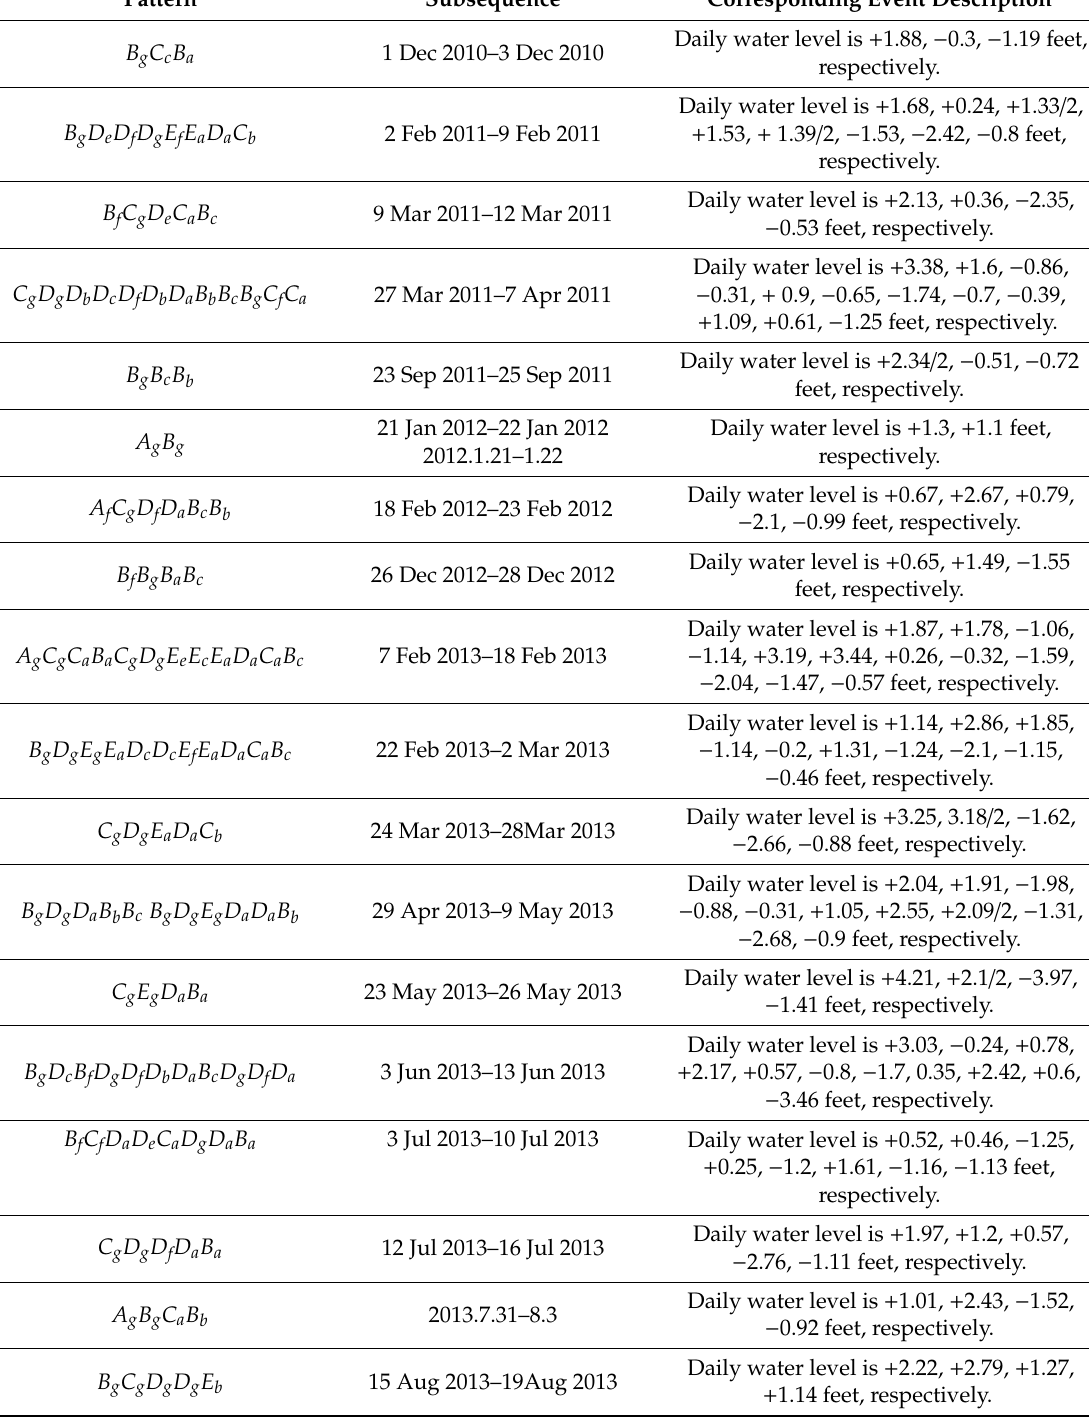
Table 4. Anomalous patterns detected by the algorithm and event descriptions. Pattern Subsequence Corresponding Event Description B g C c B a